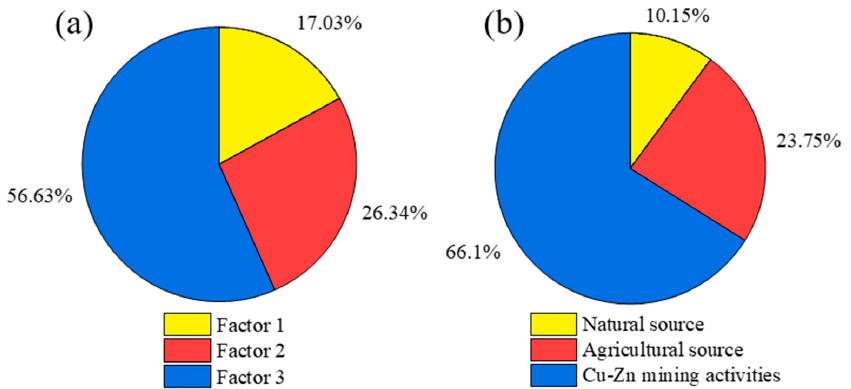
Figure 7. Contributions of various sources to the sediment heavy metal concentrations ( a ) and the associated ecological risks ( b ) in the study area.